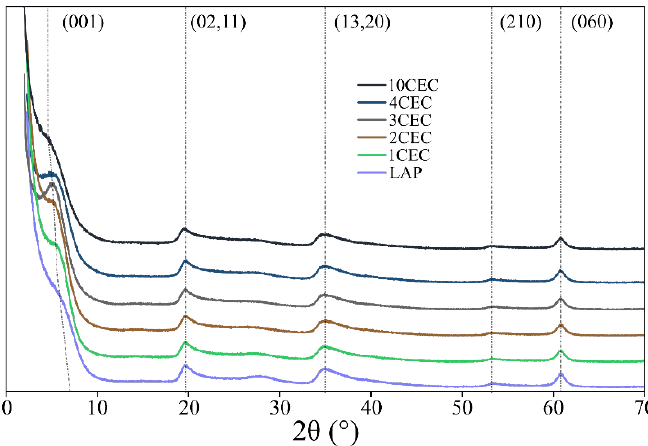
Figure 1. X-ray diffraction patterns of LAP and LAP-APTES for different loads of grafting agents. Figure 1. X-ray di ff raction patterns of LAP and LAP-APTES for di ff erent loads of grafting